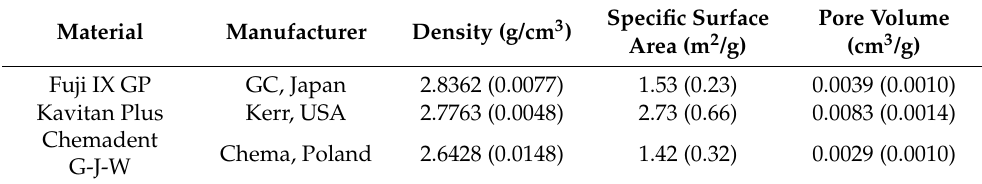
Table 3. Details of commercial ionomer glass powders (standard deviations in